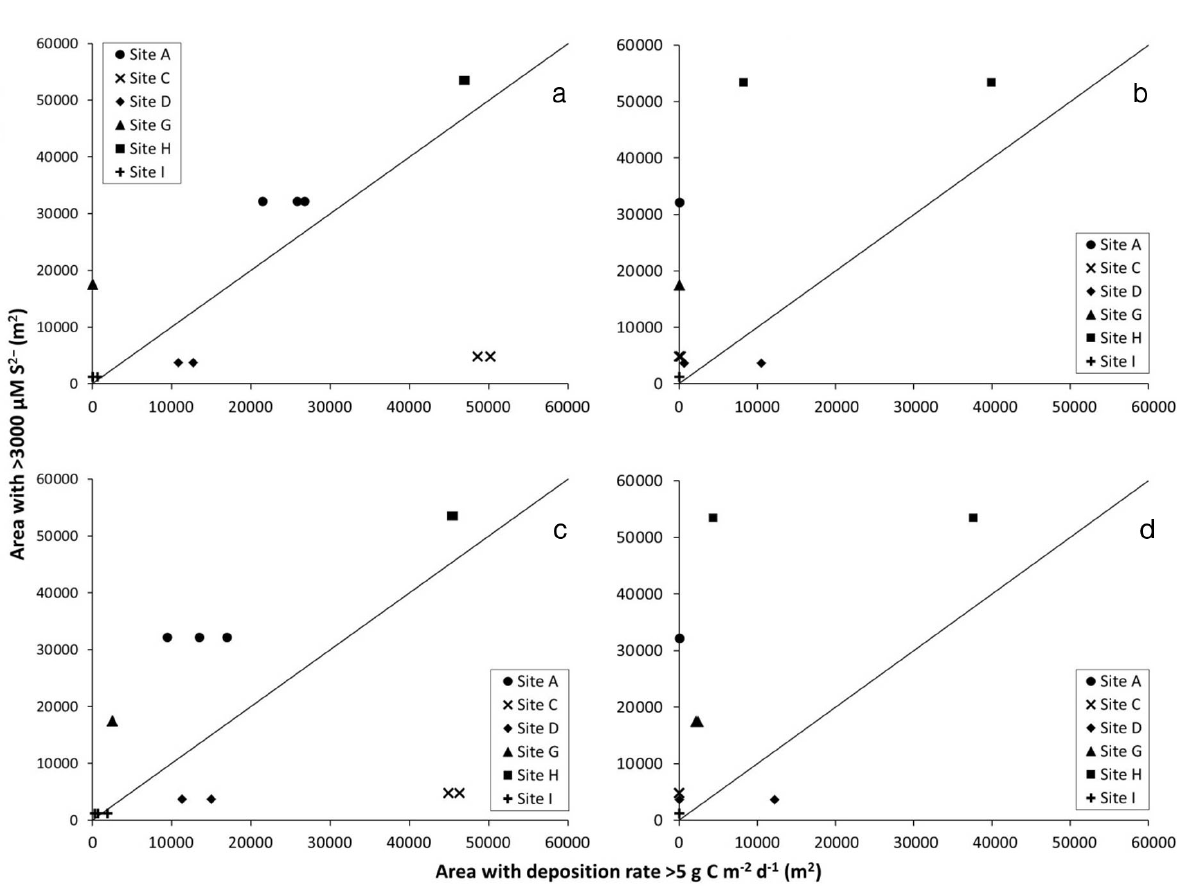
Fig. 7. Relationships between the spatial extent of seafloor area with elevated impacts predicted by DEPOMOD (deposition rate >5 gC m −2 d −1 ) and the seafloor area with elevated sediment sulfide concentrations (>3000 µM). DEPOMOD runs using average daily feeding rates during (a,b) 1 mo periods and (c,d) 3 mo periods including the sediment sampling date, (a,c) without resuspension and (b,d) with resuspension. The line represents a 1:1